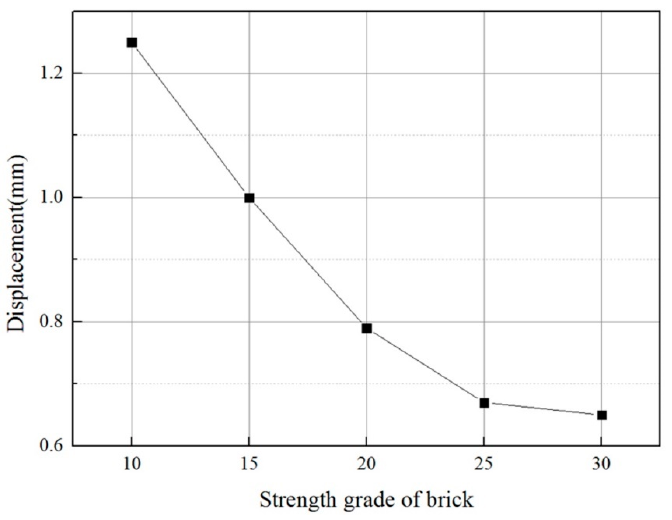
Figure 16. Variation curve of the horizontal displacement at the initial cracking of the interface with the strength grade of bricks.